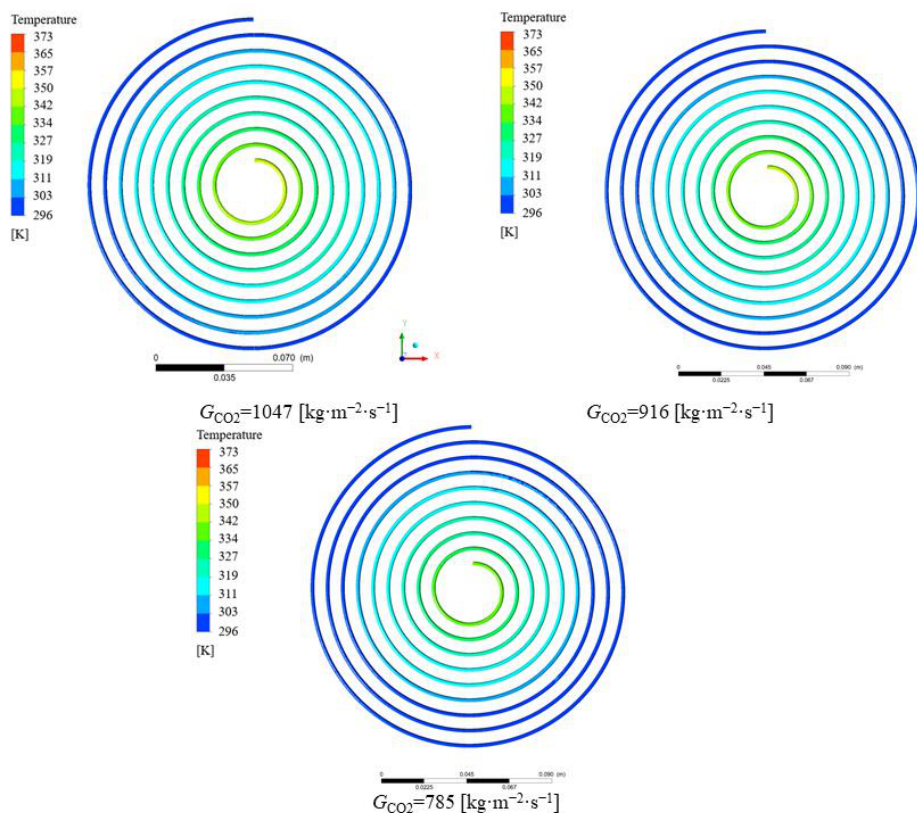
Figure 14. Variation in the average heat transfer coefficient of CO 2 at different mass fluxes.